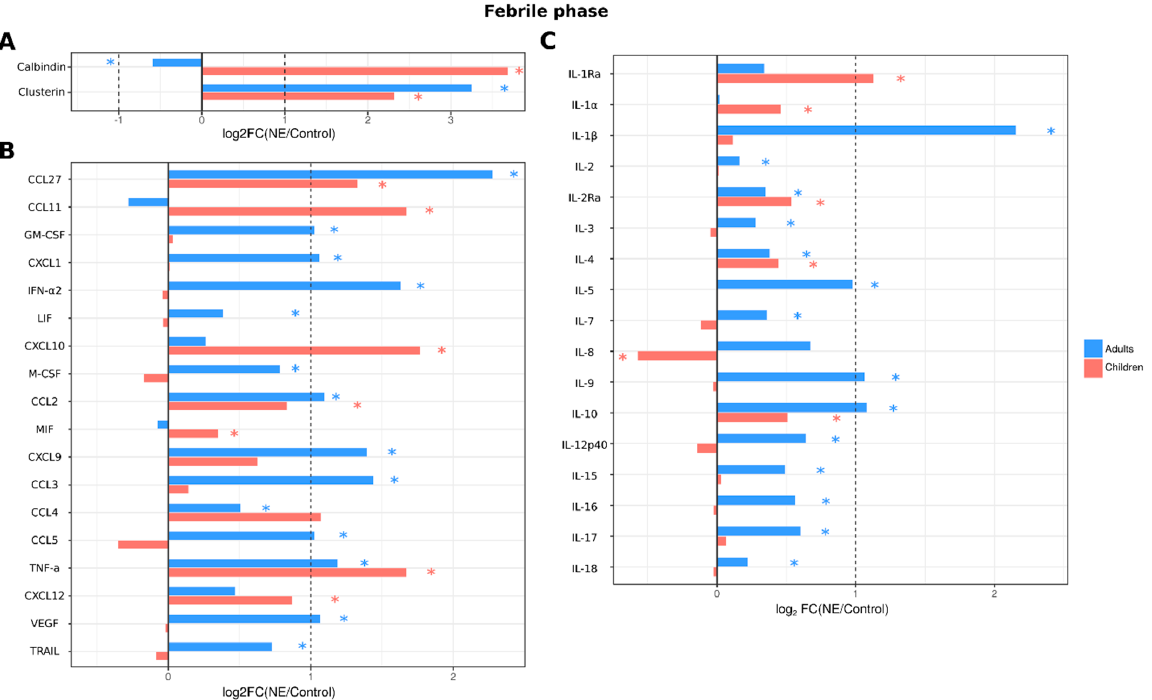
Figure 4. Analysis of serum cytokine and kidney toxicity markers in adults and children diagnosed with NE in the febrile phase. The Bio-Plex (Bio-Rad, Hercules, CA, USA) multiplex magnetic bead- based antibody detection kit was used to measure ( A ) markers of kidney toxicity in the urine; ( В ) serum chemokines or ( С ) serum interleukins in adults ( n = 129) and children ( n = 11). Data are presented as Log2 fold change in comparison to non-NE control samples. Asterisks denote statistical significance determined by Kruskal-Wallis test with BH adjustment ( p < 0.05). Dotted line indicates fold change of 1.